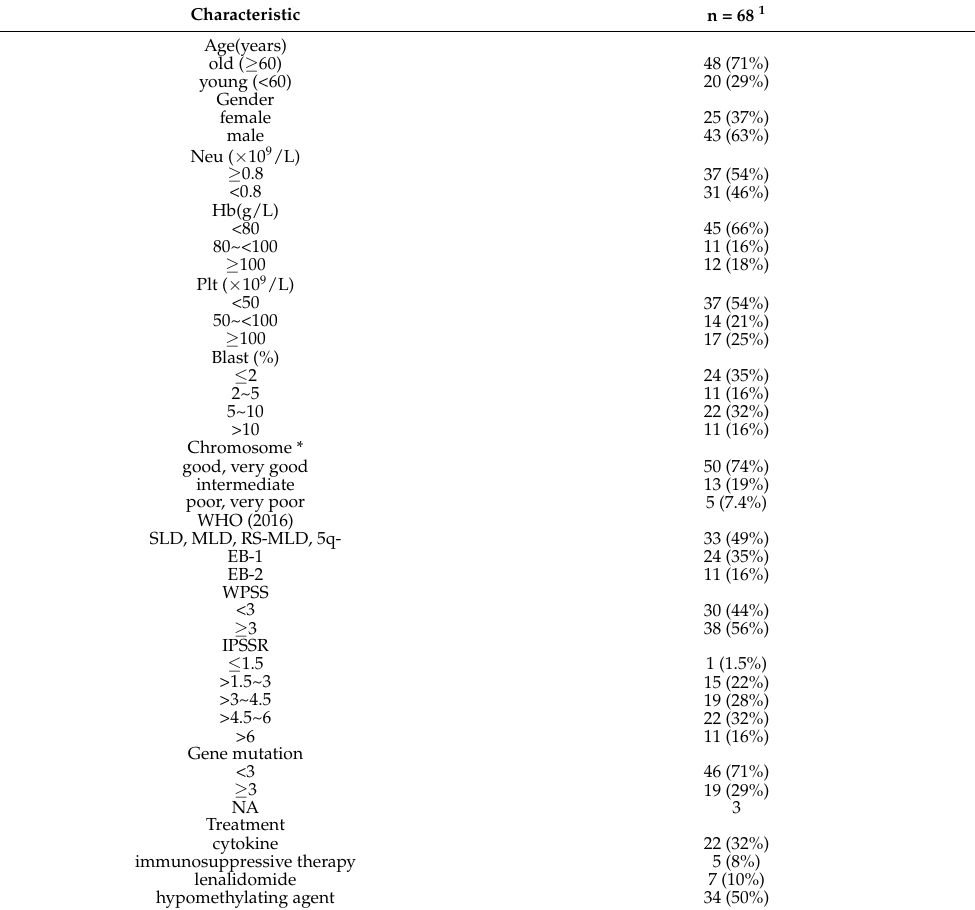
Table 1. Clinicopathological characteristics in